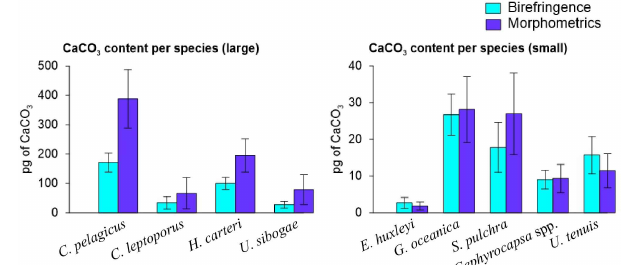
Figure 5. Total annual CaCO 3 export (chemically determined) and fractional contribution of coccolithophores to CaCO 3 estimated us- ing birefringence (C-Calcita) and morphometric approaches for the SOTS and SAM